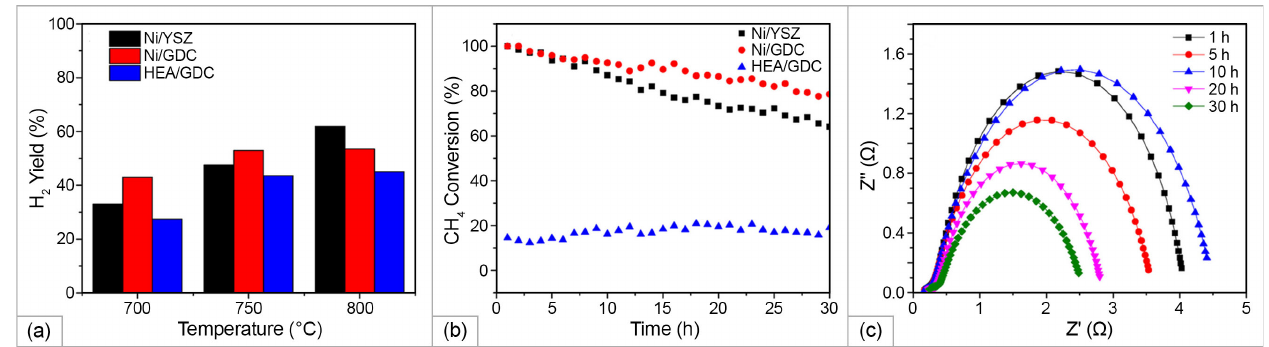
Figure 8. Methane steam reforming using Ni/YSZ, Ni/GDC, and HEA/GDC anode catalysts: ( a ) yield of hydrogen at reaction temperatures of 700, 750, and 800 °C, 1 atm, S/C = 2 and GHSV = 45,000 1/h; ( b ) time-on-stream stability test at 600 °C and S/C = 1 for 30 h; ( c ) time dependence of the overall ohmic and non-ohmic resistance of the HEA/GDC-Ni/ScSZ|ScSZ|LSM/YSZ cell at 750 °C (reproduced from [95]).